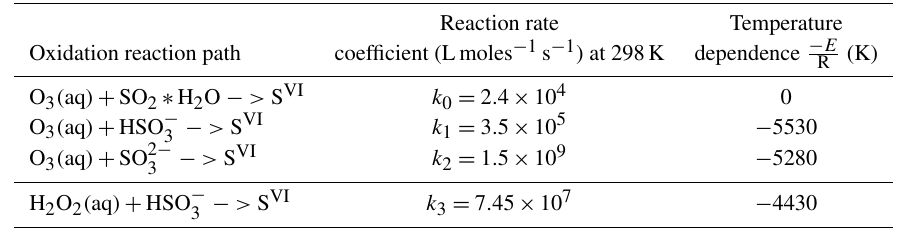
Table C5. Reaction rate coefficients and their temperature dependence coefficients (taken from Kreidenweis et al.,